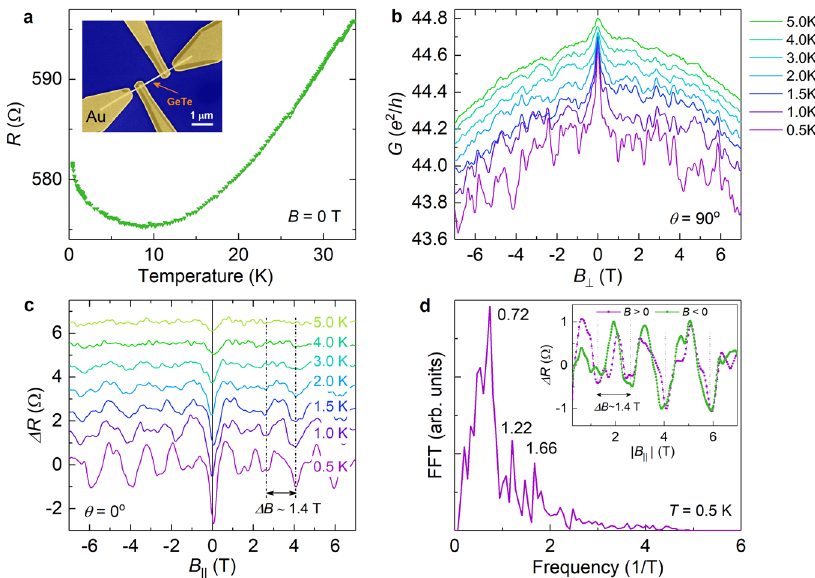
Fig. 2 Magnetotransport of a normal contacted GeTe nanowire. a Four-terminal resistance as a function of temperature at zero magnetic fi eld of a Au/GeTe-nanowire/Au device. Inset: Scanning electron microscopy image of a GeTe NW contacted with Ti/Au leads. b Conductance in units of e 2 / h as a function of B ⊥ at temperatures from 0.5 to 5.0 K. c Magnetoresistance oscillations after subtracting a parabolic background as a function of B ∣∣ at temperatures from 0.5 to 5.0 K. d Fast Fourier transform (FFT) of the magnetoresistance oscillations in a parallel magnetic fi eld at 0.5 K. The inset shows the corresponding resistance oscillations for the positive and negative magnetic fi eld range.